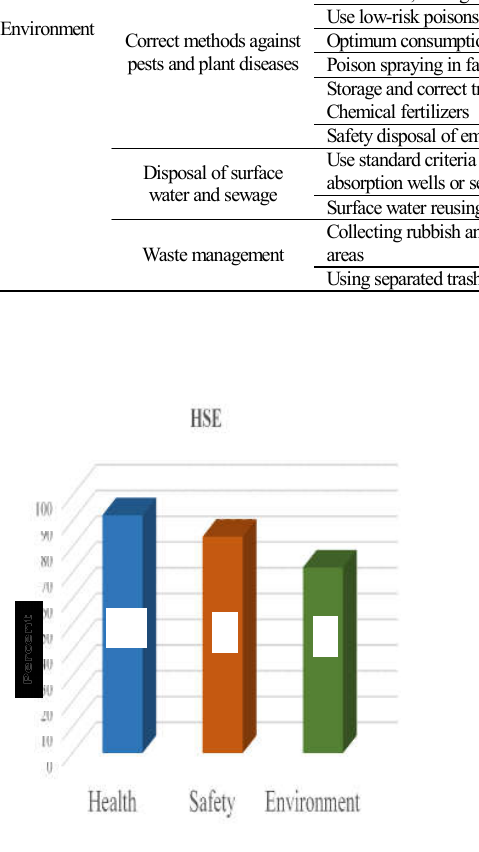
Fig. 2: Results of HSE assessment Fig. 3: Average percentage of health